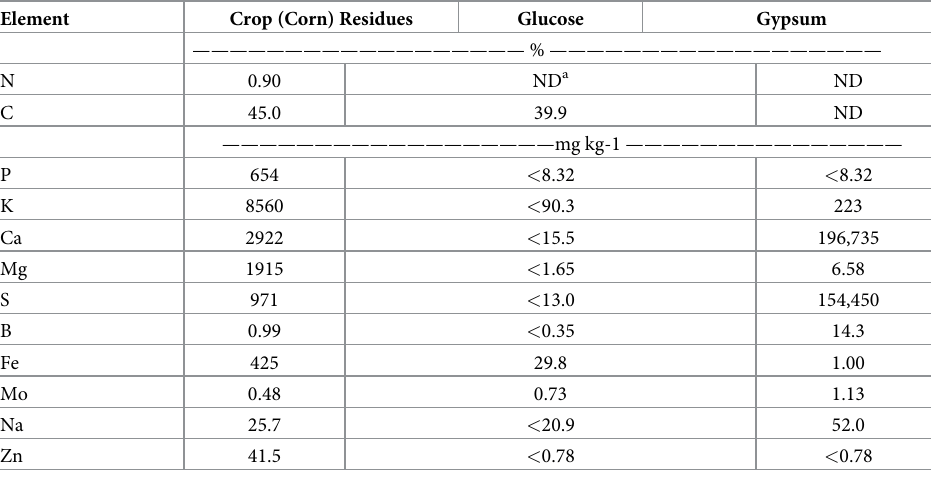
Table 2. Concentration of elements in the inputs added to the soil (Adapted from [46, 51]). Element